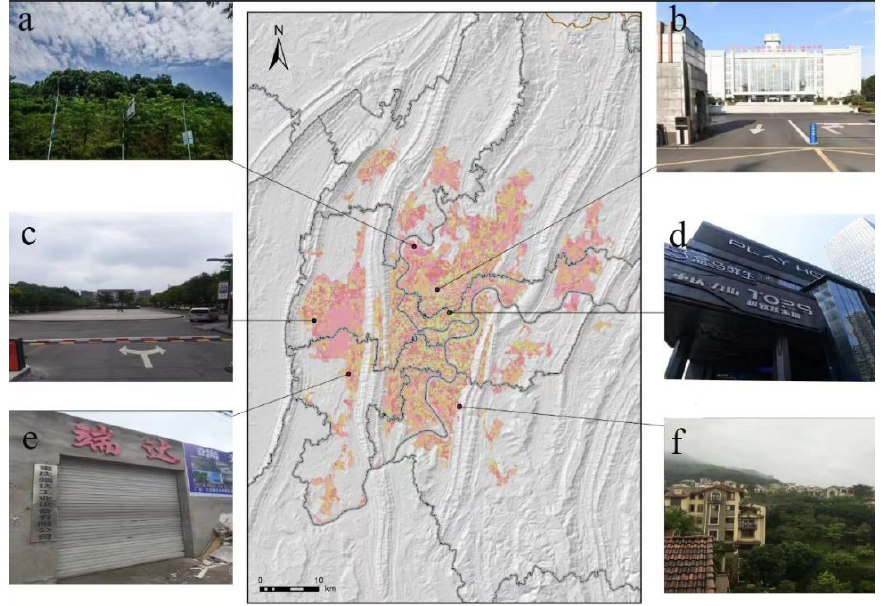
Figure 8. Baidu Street view of some single functional areas. ( a ) Baiyunzhai Park (green spaces and squares), ( b ) Fire Brigade (administration and public service), ( c ) Chongqing City Management College (education), ( d ) Paradise walk (life service), ( e ) Ruida industry (industrial), ( f ) Villa (residential service).